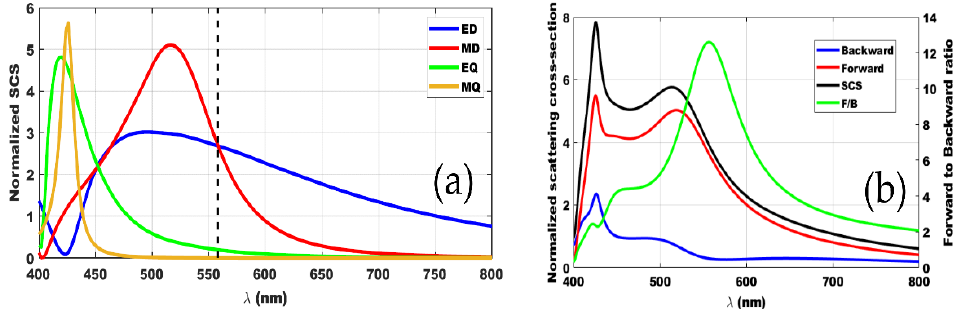
Figure 1. ( a ) Multipole decomposition of the scattering cross-section (SCS) of a single TiO 2 resonator of radius 110 nm and height 200 nm placed in air. ( b ) Forward (red) and backward (blue) scattering profile of the resonator. A resonance in the FS/BS ratio (green) can be seen very close to 550 nm where ED and MD spectrally overlap (black dashed line in Figure 1a).